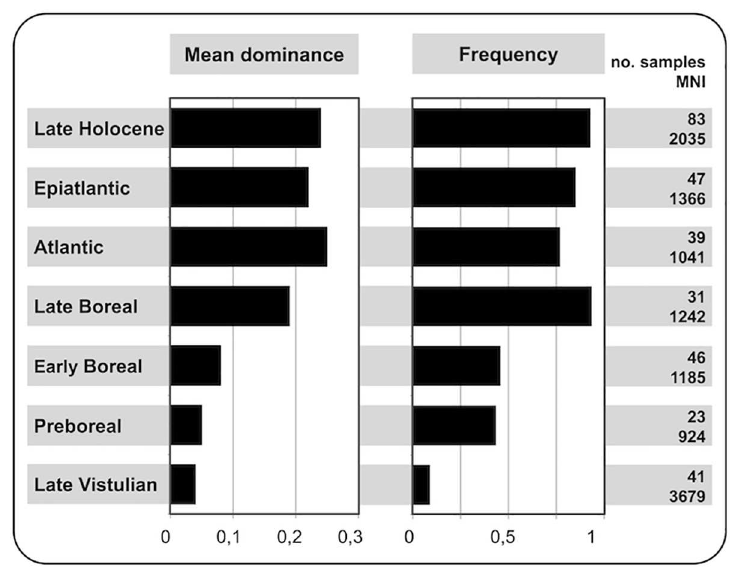
Fig 5. Mean dominance (based on MNI) and frequency of Apodemus spp. in the community samples representing particular stages of Late Pleistocene / Holocene stratigraphy–based on the sedimentary series from the Czech Republic and Slovakia (see [18] and Table 1 for a detailed list of